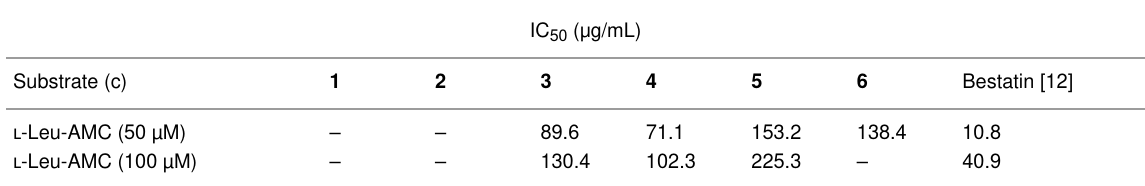
Table 3: Inhibition of ʟ -Leu-AMC hydrolysis by the metabolites 1 – 5 .